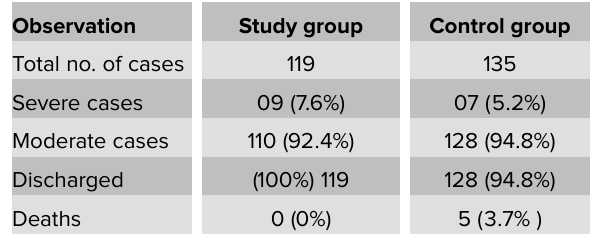
TABLE 5: Comparison between the outcomes in the two groups.